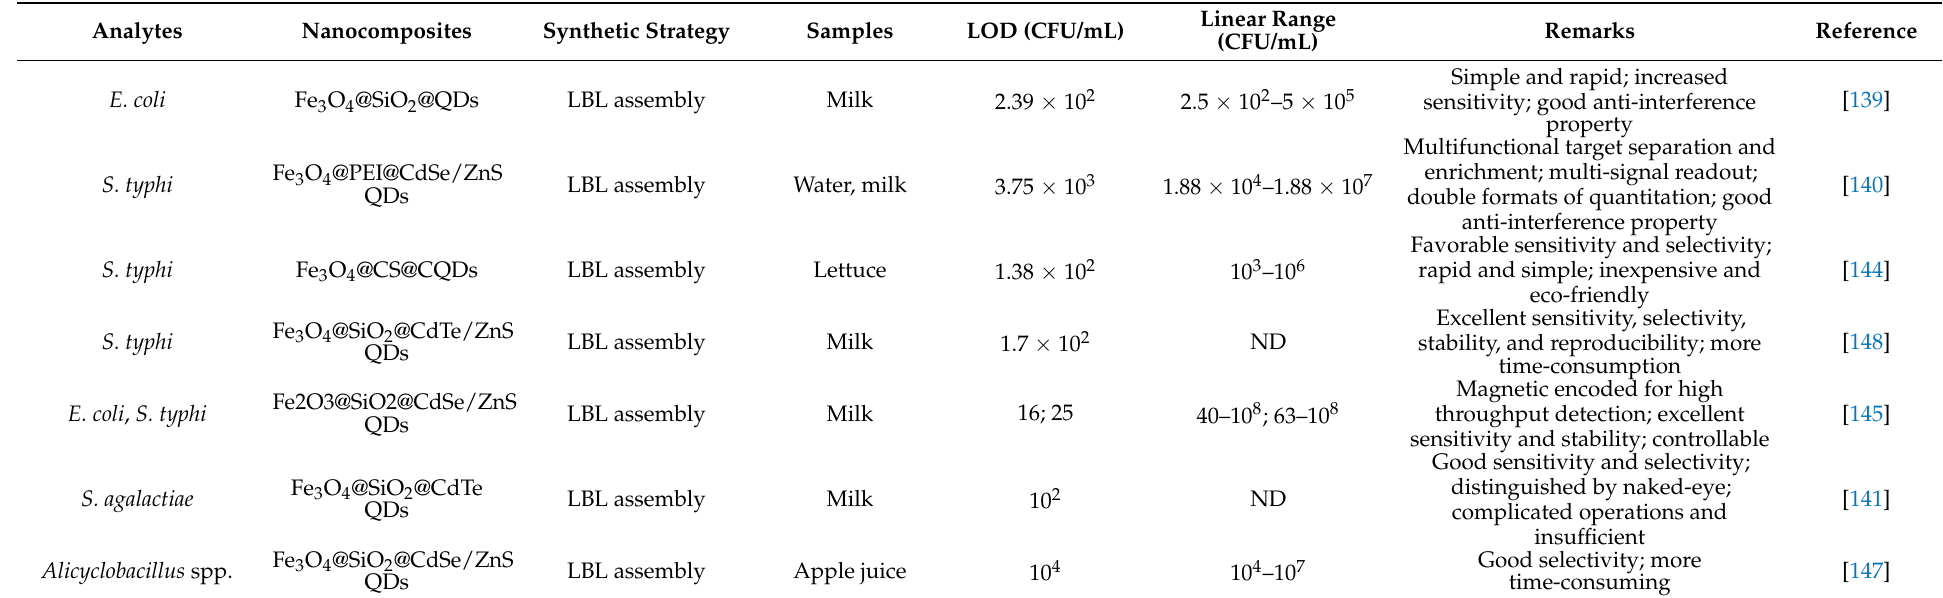
Table 2. Detection performances of MNPs@QDs-based sensors for foodborne